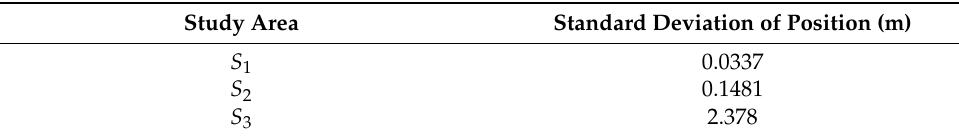
Table 7. Standard deviation of center